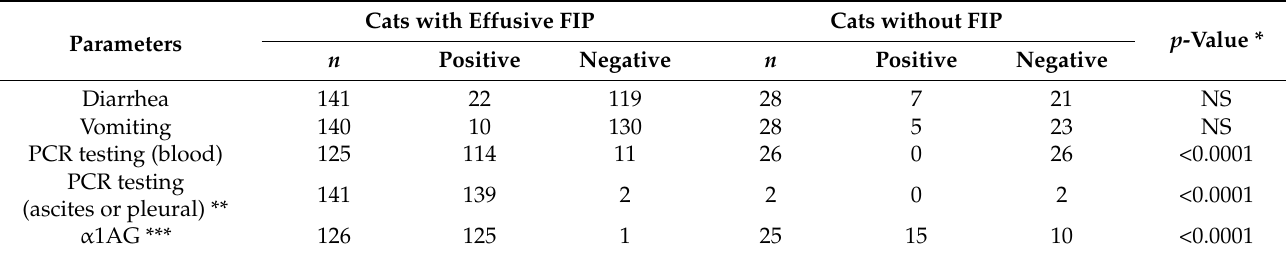
Table 2. Statistical comparison of categorical parameters between cats with and without effusive FIP. Parameters